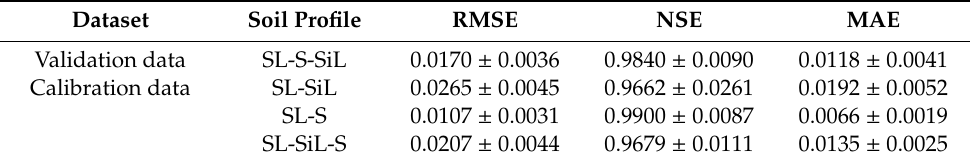
Table 3. The simulation performance using optimized parameters by Hydrus-1D.